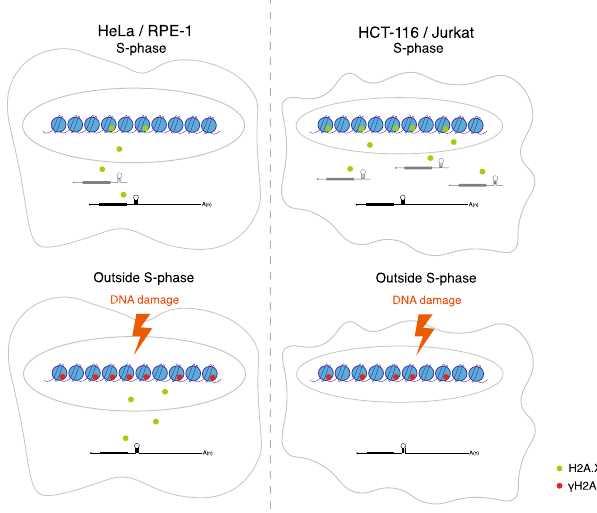
Fig. 8 Model. In S-phase HCT-116 and Jurkat cells express increased H2A.X SL mRNA compared to HeLa and RPE-1 cells, so that they synthesise and incorporate more H2A.X protein into the newly made chromatin. Following DNA damage (etoposide treatment or UV irradiation), HeLa cells employ de novo H2A.X synthesis from H2A.X poly(A) mRNA to provide suf fi cient H2A.X for ef fi cient γ H2A.X signalling. In contrast, HCT-116 cells already contain suf fi cient H2A.X in chromatin to signal DNA damage, so obviating the need for de novo H2A.X